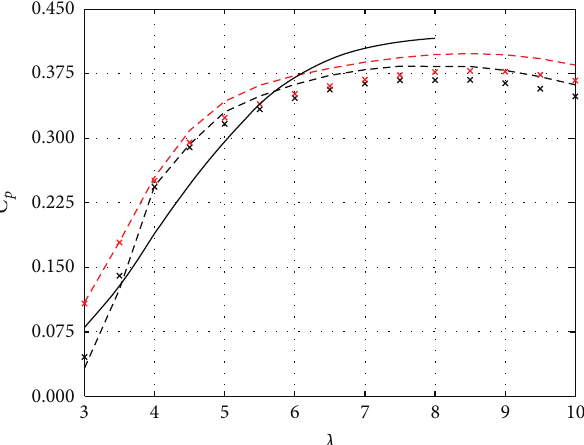
Figure 11: 𝐶 𝑝 versus 𝜆 obtained experimentally (solid line) and with the extended BEM algorithm for 𝑈 ∞ = 11.1 m/s. Model input: = 7 , AERODAS (black) or Viterna (red), tip loss model on 𝑁 crit (dashed line) or off (cross